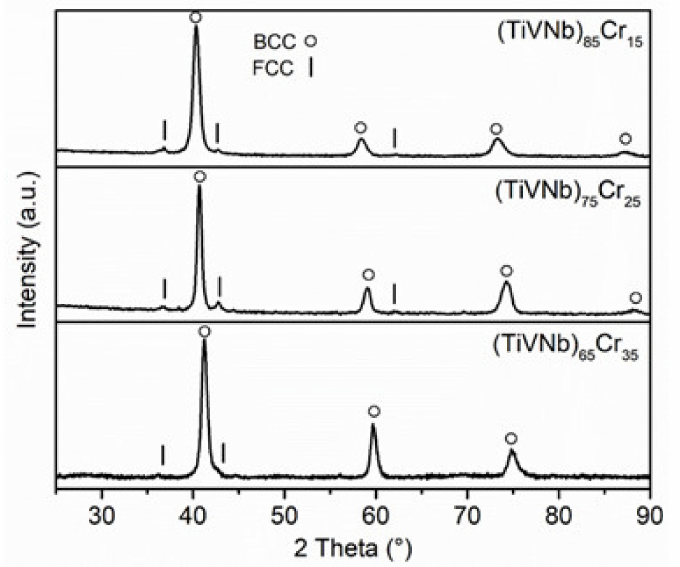
Figure 4. Indexed XRD patterns for samples in as cast condition. Alloys’ compositions are indicated on the